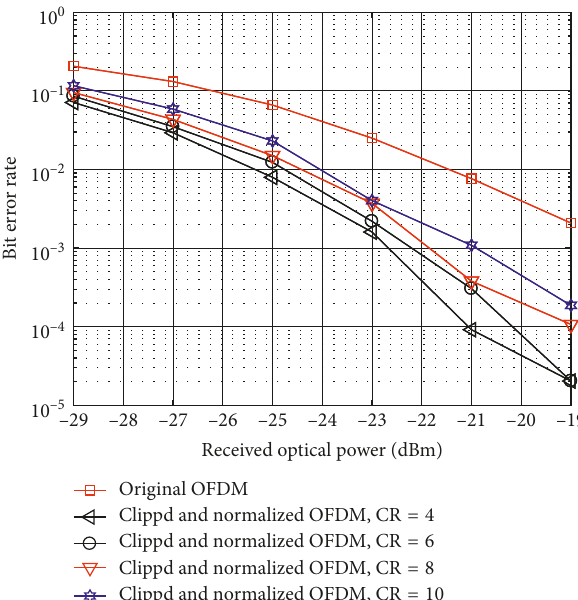
Figure 11: Comparison of the BER performance of the clipped and normalized QPSK OFDM signals with the launch power of 6dBm.